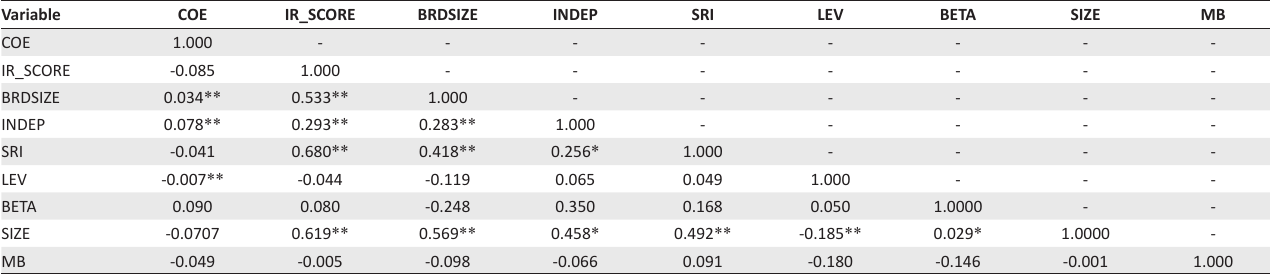
TABLE 3: Correlation: Cost of equity and independent variables.